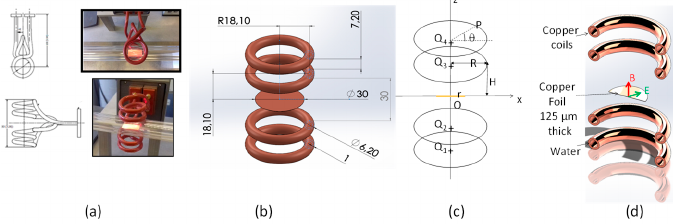
Figure 1. Inductive heating set-up: ( a ) Top and side views of the circular magnetic induction coils placed symmetrically on both sides of a thin copper foil; ( b ) Schematic drawing of Helmholtz coils used for the inductive heating; ( c ) Simplified configuration used for the uniformity calculation of the magnetic field where the coils with closed geometry with a circular cross section perpendicular to the z-axis are placed symmetrically with respect to the median plane of the substrate at positions Q 1 , Q 2 , Q 3 , and Q 4 along the z-axis and connected in series with the current source; ( d ) Cross section of the coils showing the perpendicular magnetic field and orthonormal electric field.